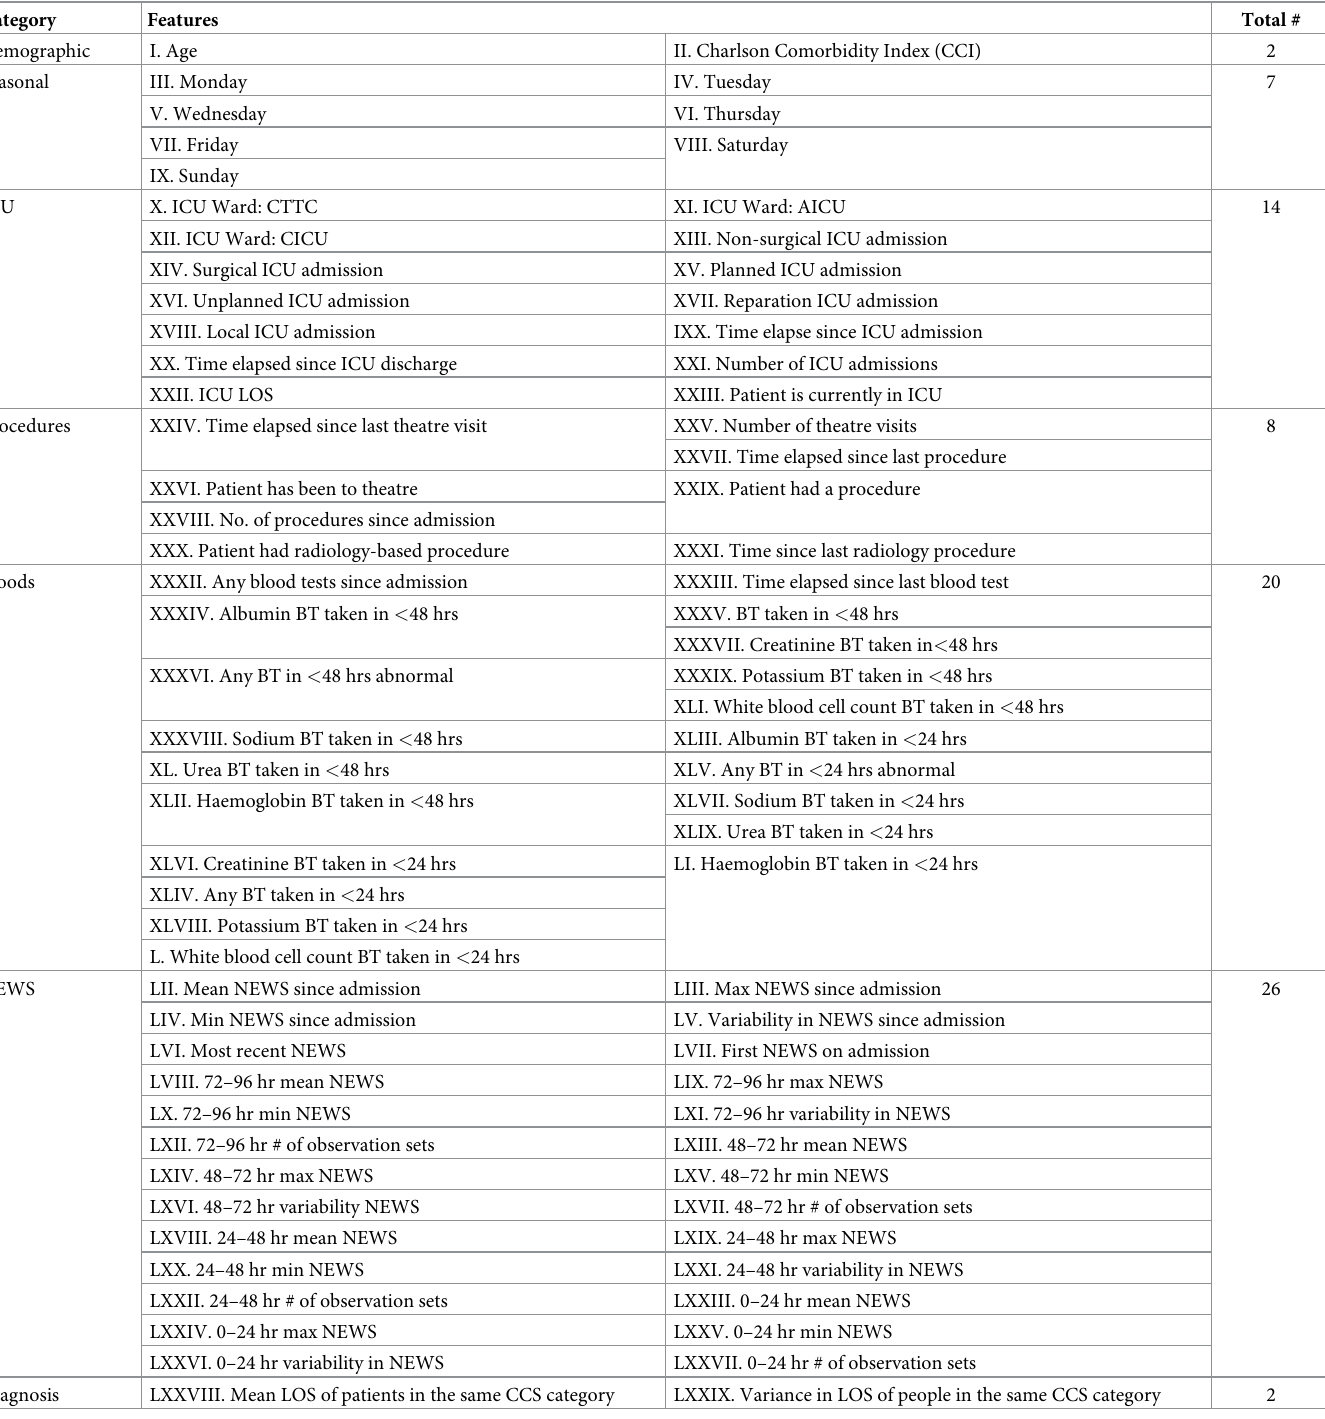
Table 4. Table of